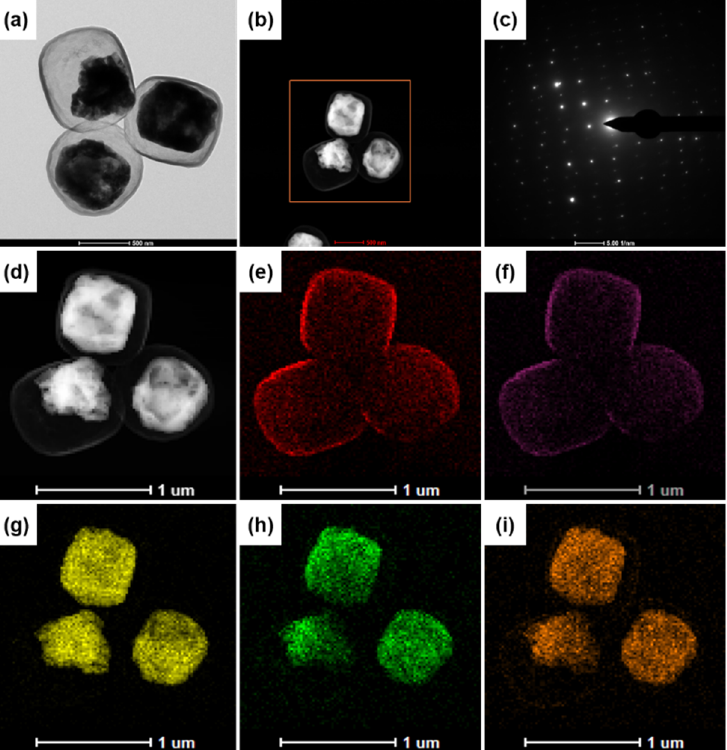
Figure 3. EDS element mapping analysis of Fe 3 O 4 @void@N-doped C-5 composite: ( a , b , d ) TEM images; ( c ) electron diffraction photograph; ( e ) C elements; ( f ) N elements; ( g , h ) Fe elements; ( i ) O elements.